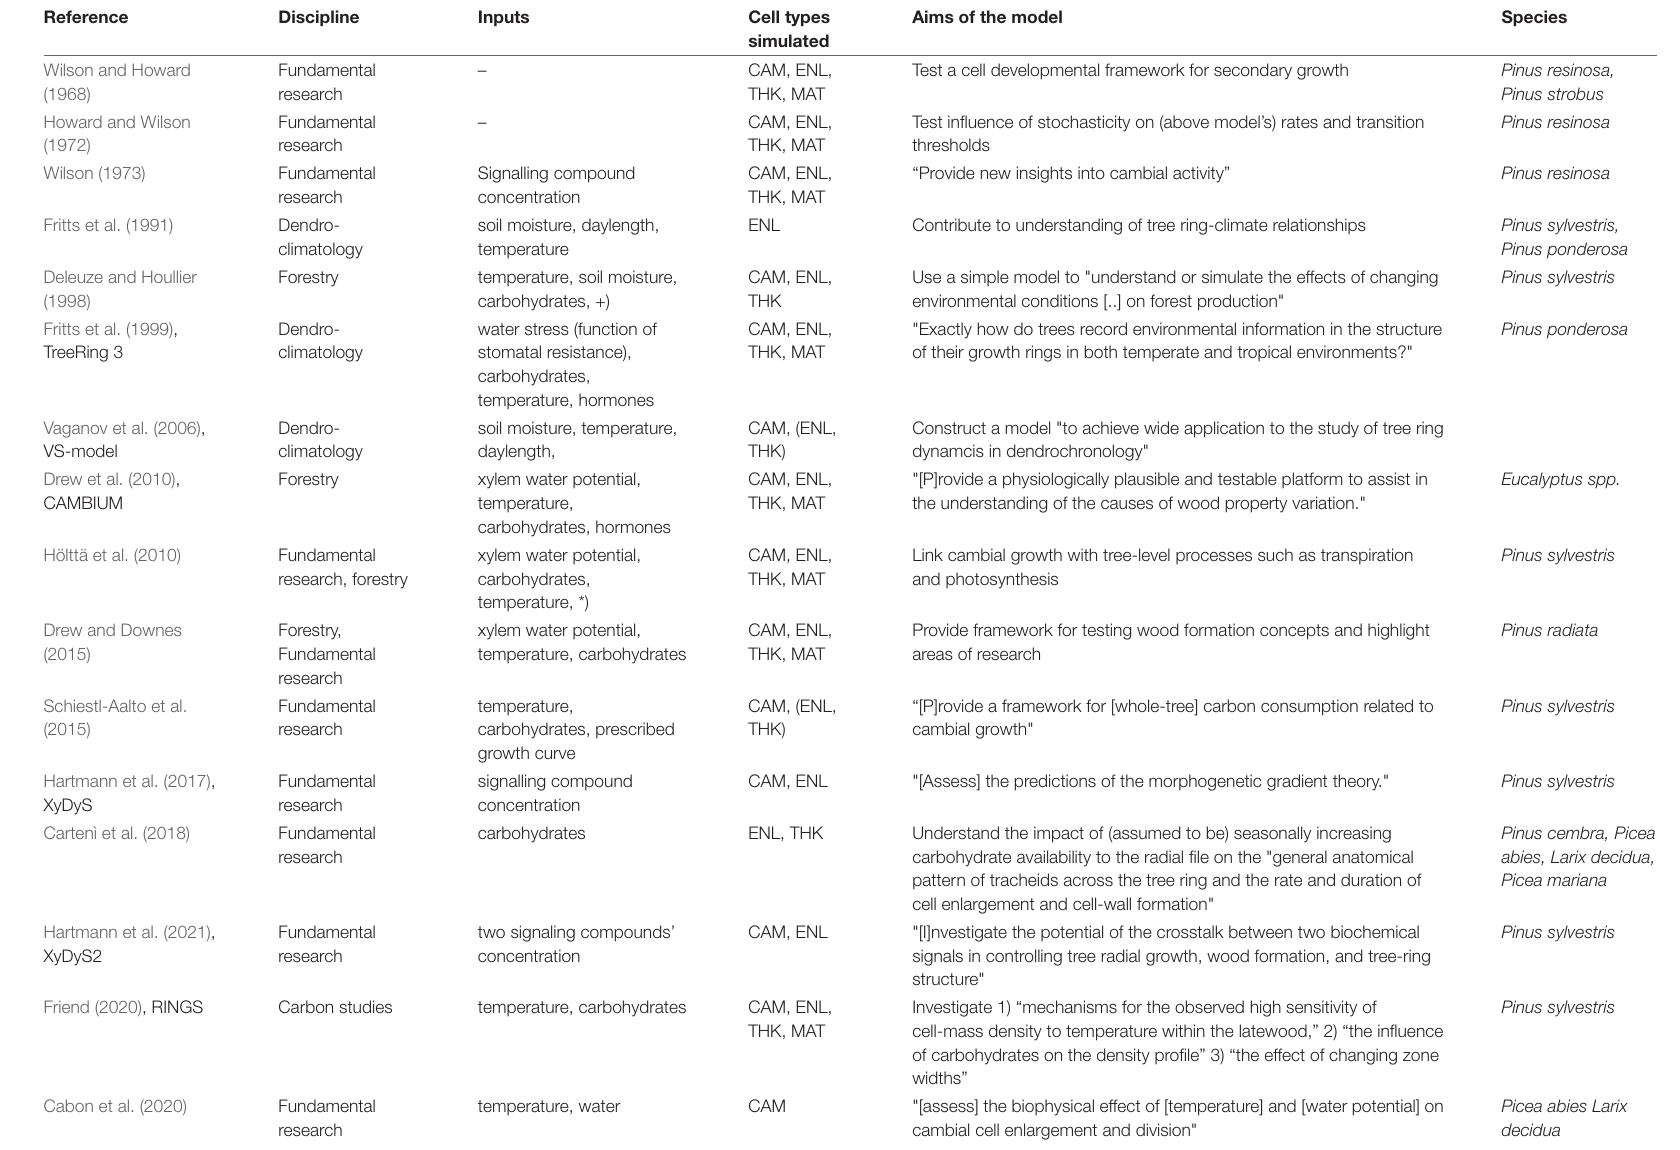
TABLE 1 | Wood formation models covered in this